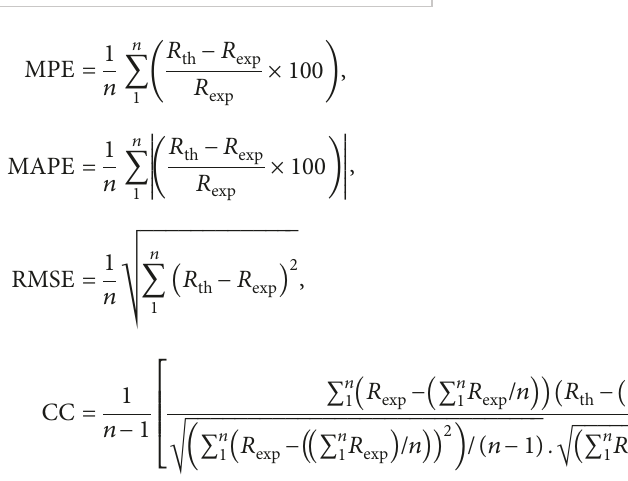
� number of neuros � 12 in this 1